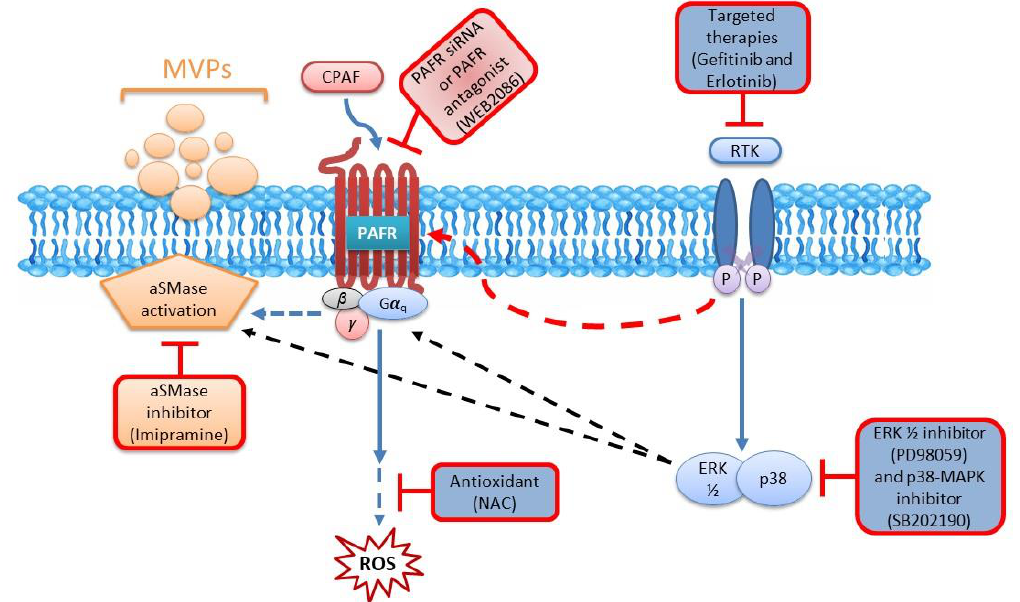
Figure 7. Schematic representation of a working model of PAFR-dependent targeted therapies-induced MVP release. In this model, targeted therapies activate the PAFR likely via the production of PAF agonists, similar to CPAF, which generates ROS in a process blocked by PAFR antagonist and antioxidant. The PAFR activation also stimulates aSMase, which involves ERK1 / 2 and p38-MAPK pathways resulting in MVPs formation and release in a process blocked by PAFR siRNA and PAFR antagonist, aSMase inhibitor, and ERK1 / 2 and p38-MAPK